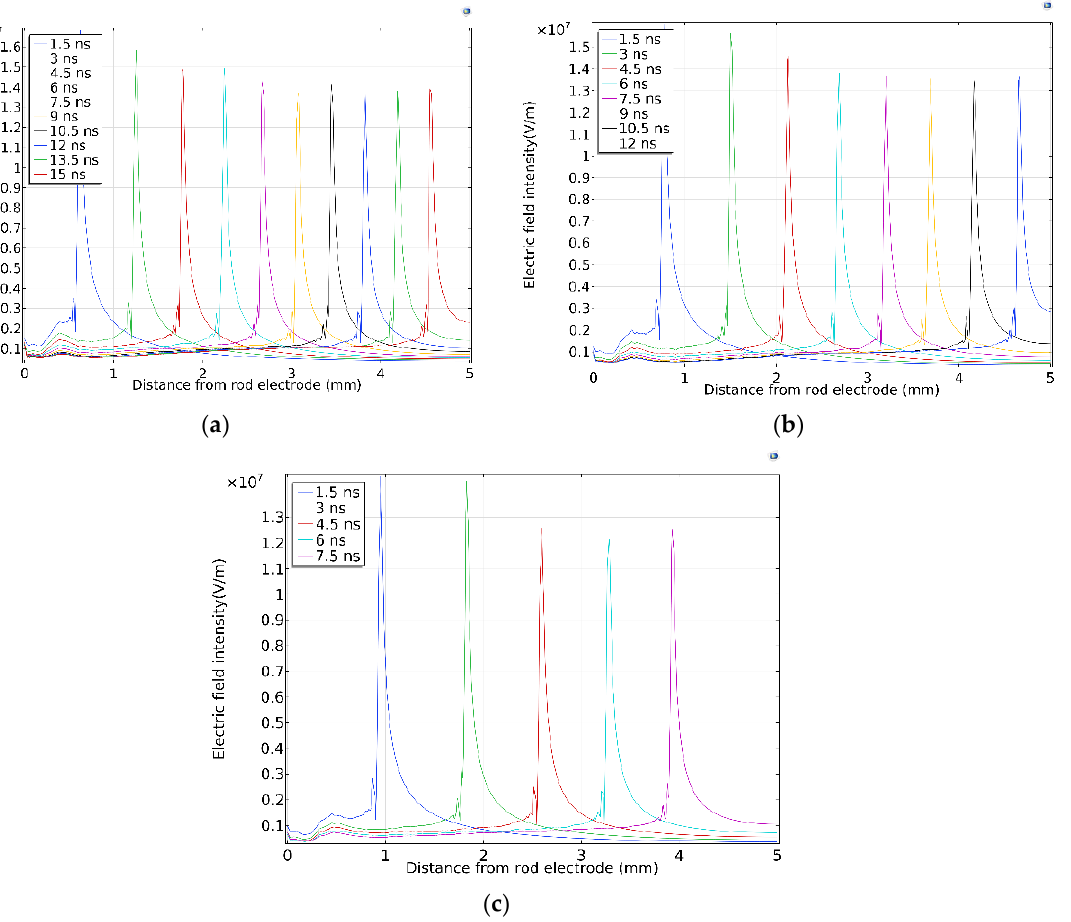
Figure 7. One-dimensional distribution of electric field intensity along the axis: ( a ) 101 kPa, ( b ) 85 kPa, ( c ) 70 kPa.